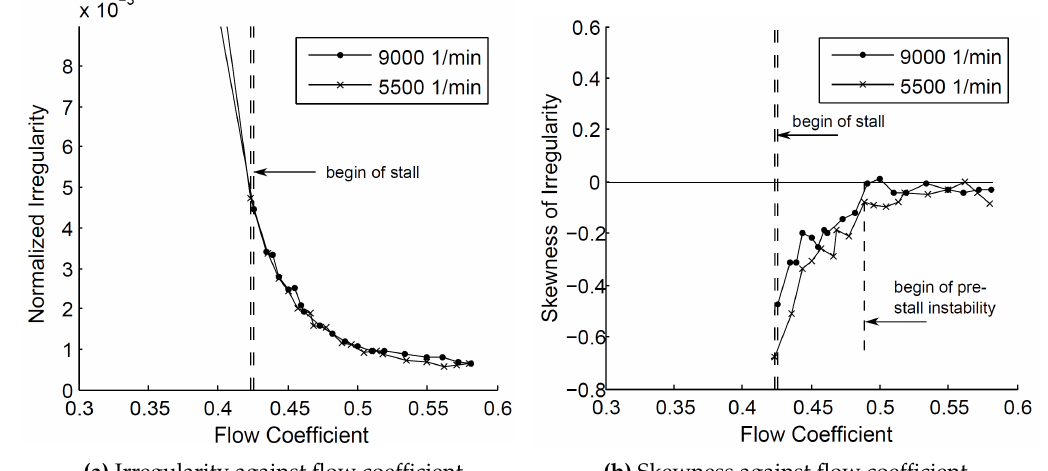
Figure 5. Identification criteria for the detection of prestall disturbances (Experiment).